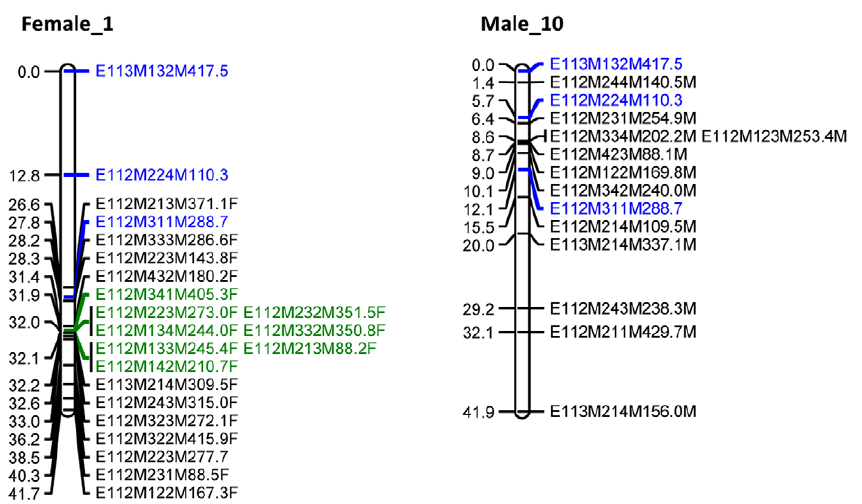
Figure 4. Artemiafranciscana sex linkage groups. Female linkage group Female_1 corresponds with the W chromosome. The homologous male linkage group Male_10 corresponds with the Z chromosome. Each AFLP marker is represented by (1) a code referring to the corresponding PC (Table S1), followed by (2) the molecular size of the fragment in nucleotides and (3) the type of marker (female marker, tagged as ‘‘F’’, male marker, tagged as ‘‘M’’, biparental marker, no tag). Common biparental markers are indicated in blue. Markers fully linked to sex are marked in green. Cumulative marker distances (cM) are indicated on the left.